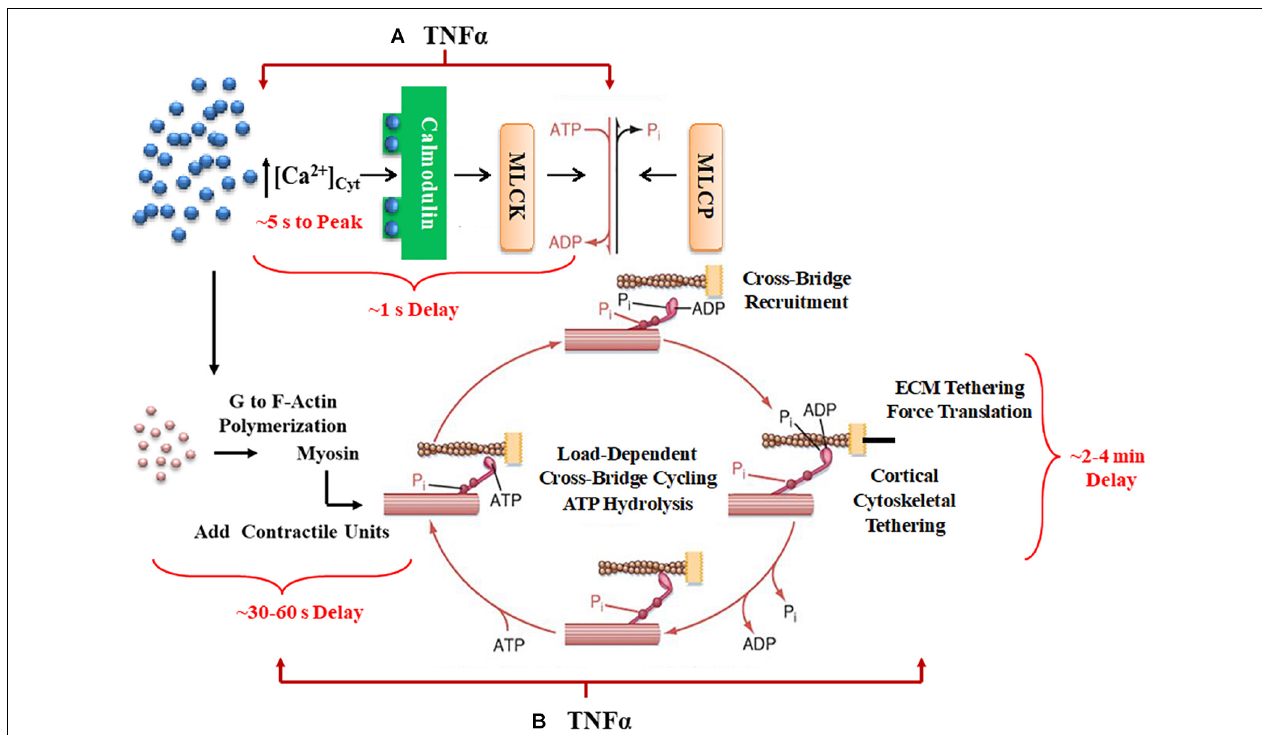
FIGURE 1 | A summary schematic illustrates how TNF α would affect not only short-term time delays reflecting rMLC 20 phosphorylation (A) but also would influence longer-term delays in contractile unit recruitment and internal loading in ASM. (B) Activation of ligand-gated or voltage-gated receptors channels by an agonist gives rise to an increase in [Ca 2 + ] cyt concentration. The increased Ca 2 + binds to calmodulin (CaM) and then this Ca 2 + -CaM activates myosin light chain kinase (MLCK) phosphorylating rMLC 20 , which in turn allows cross-bridge (actin interaction with myosin) recruitment. When cross-bridges are formed, force is generated and transferred to the sarcolemma through the cortical cytoskeletal (actin filaments, dense bodies, and intermediate filaments) that links the contractile units to the plasma membrane. In turn, the plasma membrane of ASM cells attaches to the extracellular matrix (ECM). Cross-bridge cycling is driven by the hydrolysis of ATP. The increase in [Ca 2 + ] cyt concentration also enhances G to F-actin polymerization which contributes to the number of contractile units. Myosin light